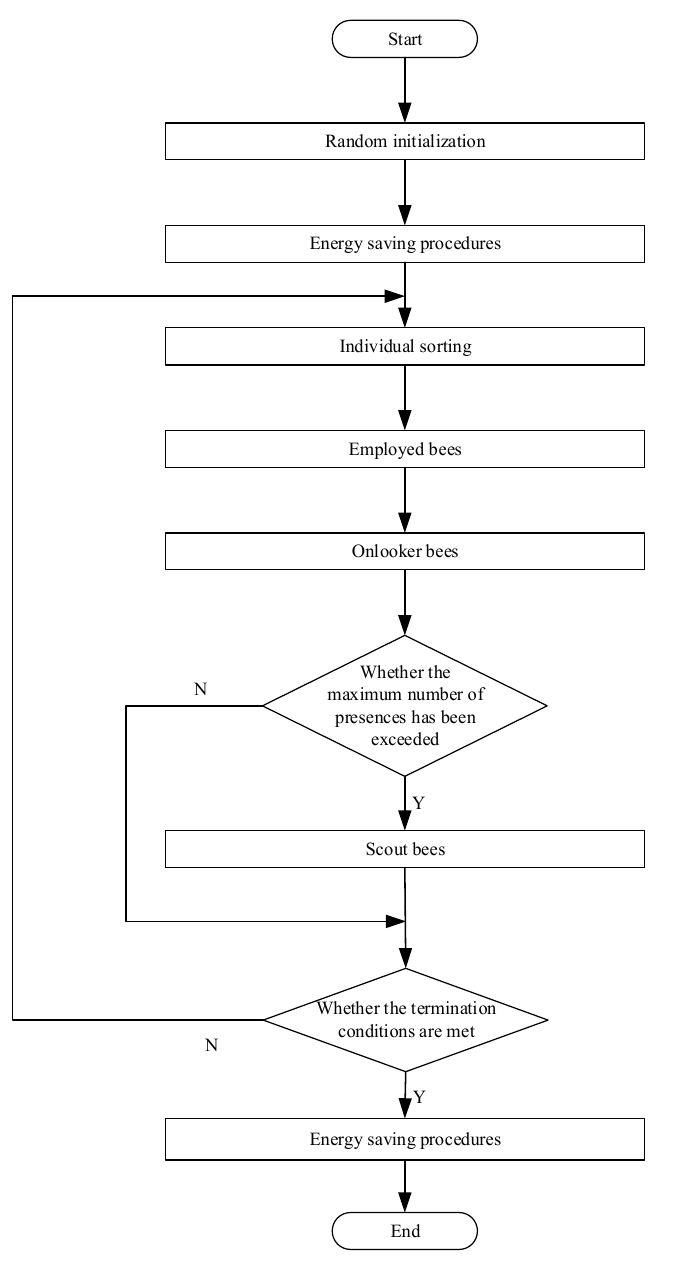
Figure 1. The overall flow of the SDABC.